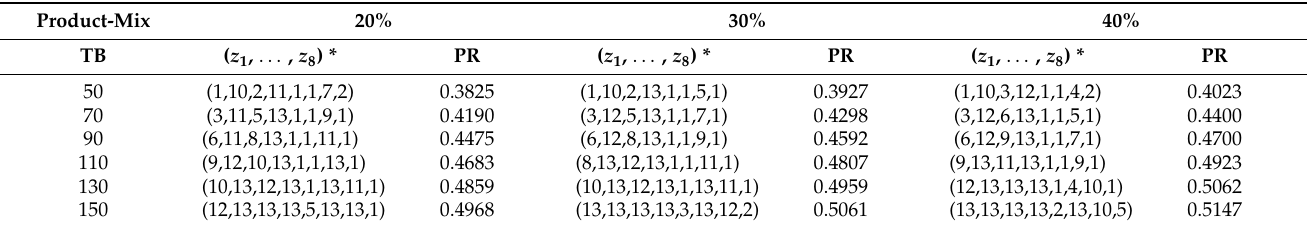
Table 10. Results of buffer allocations for changing product-mix (strategy